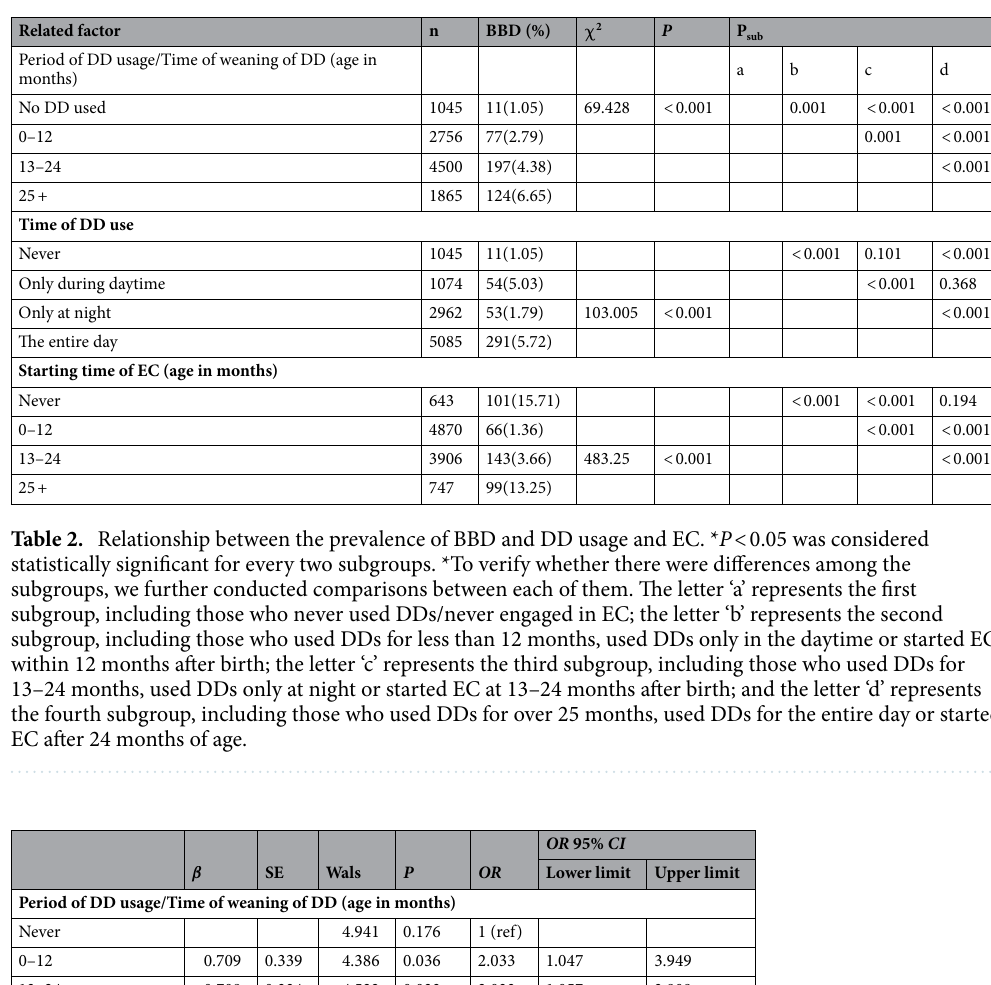
Never 55.650 < 0.001 1